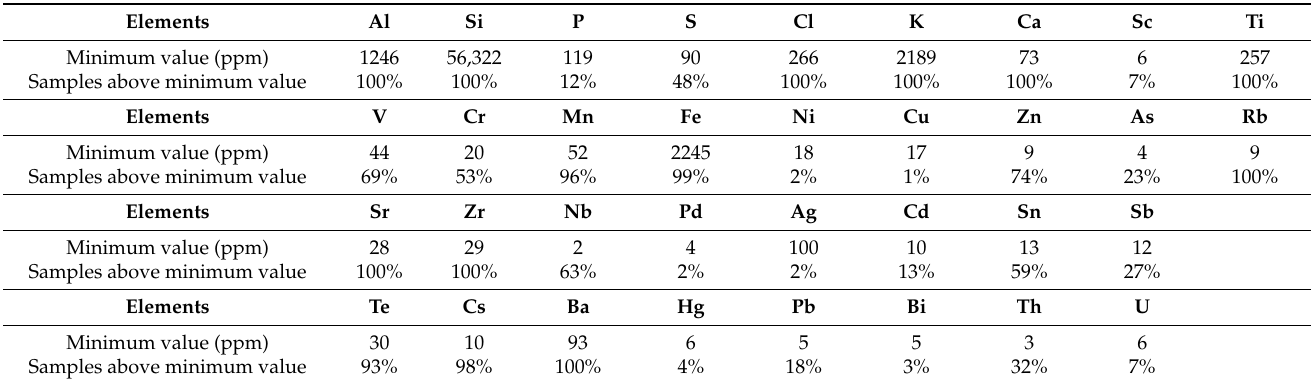
Table 3. Summary of reported elements showing the minimum detected value for each in the Ravenglass Estuary.